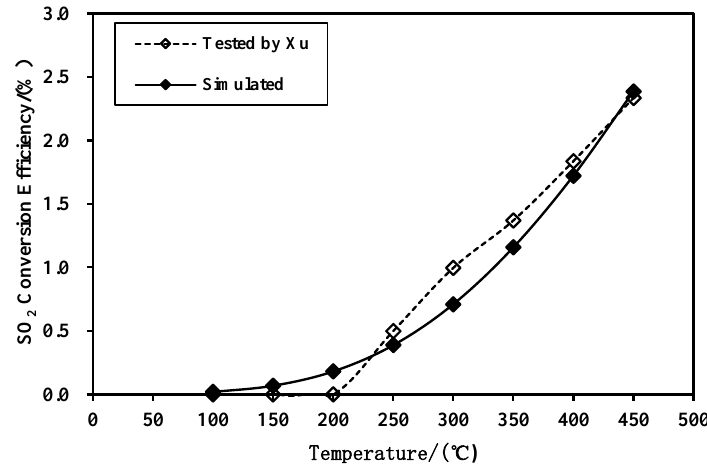
Figure 21. Experimental and simulation results of SO 2 conversion efficiency at different temperatures.